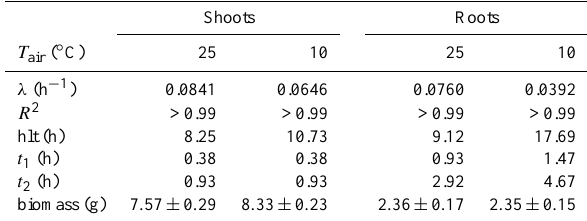
Table 1. Overview of biomass, time lags and half-life times be- tween treatments. Decay constant ( λ) of exponential decay fit us- ing f (t) = y 0 + ae − λt , corresponding coefficient of determination for exponential decay fit ( R 2 ) , derived half-life (hlt); time lag to the first appearance of the label ( t 1 ) ; time lag to the maximum induced enrichment of the label ( t 2 ) . The above- and belowground biomass at seven days after the start of the labelling and temperature treat- ments are also provided (mean ± 1 standard error, n =